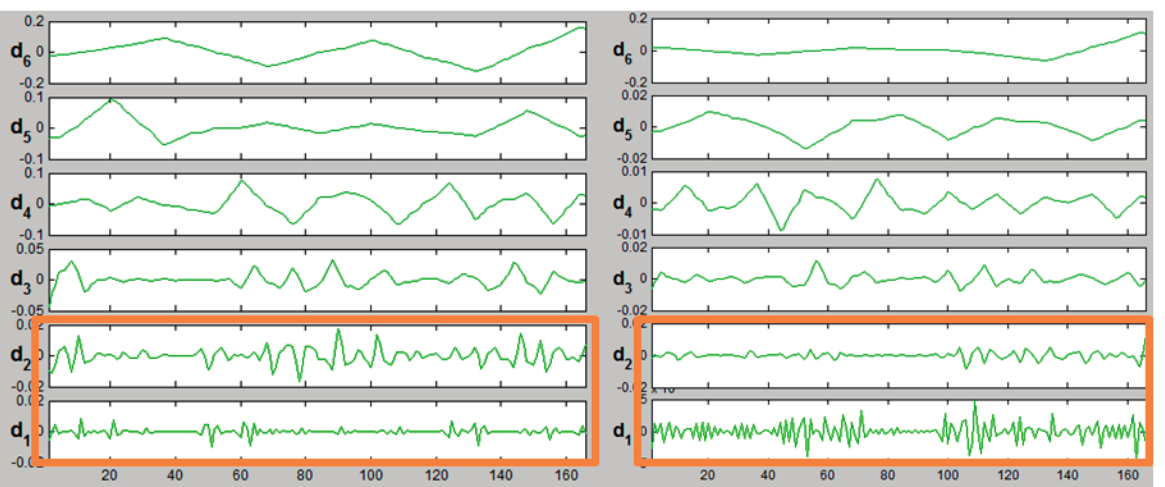
Figure 16. Details of d1–d6 respectively for XA_kE3 (ALS on the left) and XT_kE3 (TLS on the right); “sym3”, level